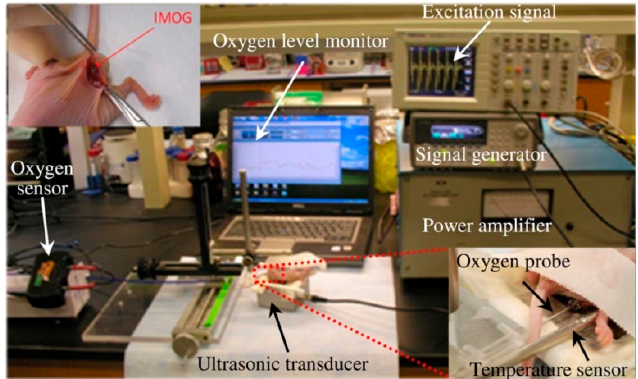
Figure 45. Experimental setup for real-time in vivo oxygen measurement during tumor oxygenation by IMOG [206]. Copyright © 2011, IEEE.